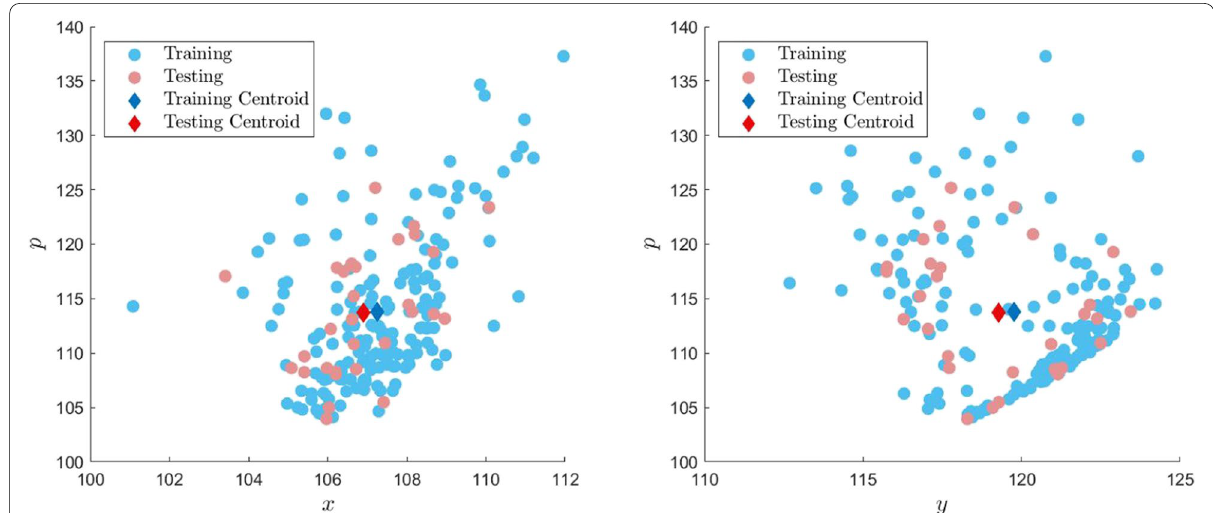
Fig. 28 Comparison of clusters for the training and testing datasets of the concrete